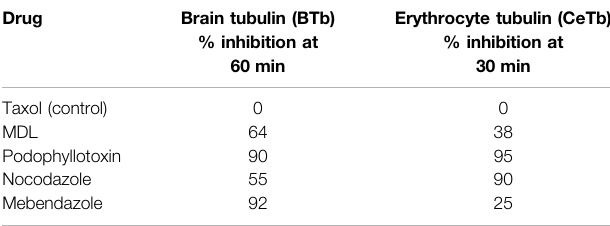
Polymerization in presence of taxol alone was considered the 100%. Tubulin was used at 2 μ M, Taxol at 2 µM and drugs were used at 20 µM in polymerization buffer at 30 °